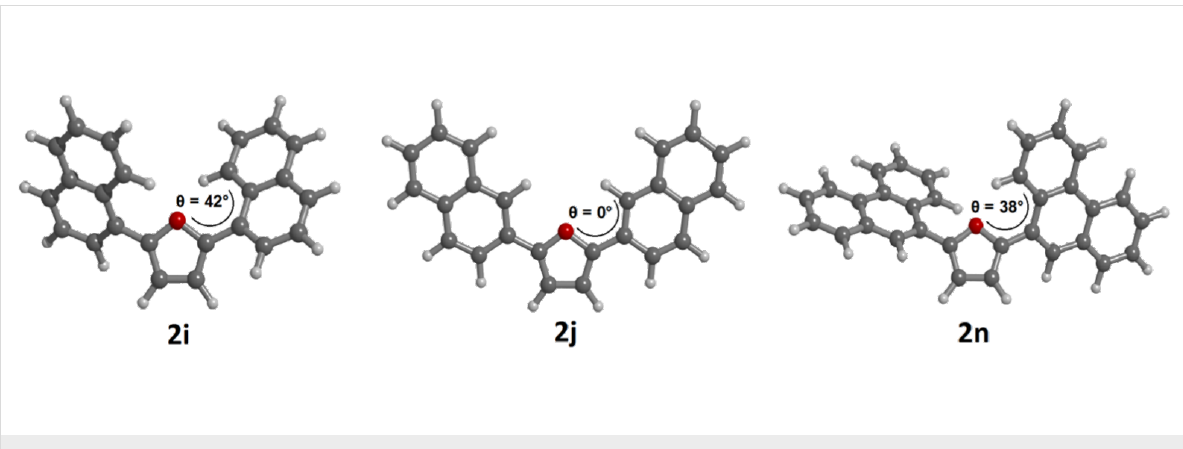
Figure 2: Selected computed minimum conformations of the 2,5-diarylfurans 2i , 2j , and 2n .